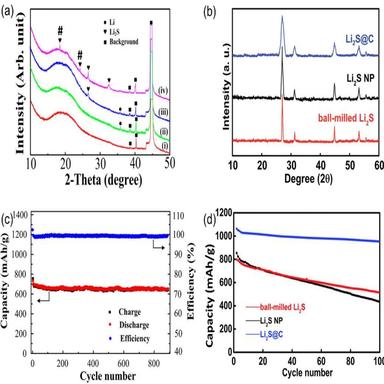
The XRD patterns of (a) Li2S@MC composites ((i) S@MC; (ii) SLMP-S@MC; (iii) compressed SLMP-S@MC; (iv) the obtained Li2S@MC after electrolyte addition), and (b) Li2S@C by CVD. The specific capacity of (c) Li2S@MC electrodes and (d) Li2S-NCs@C at 0.1C. Reproduced from Refs. with permission from the American Chemistry Society and Royal Society of Chemistry.